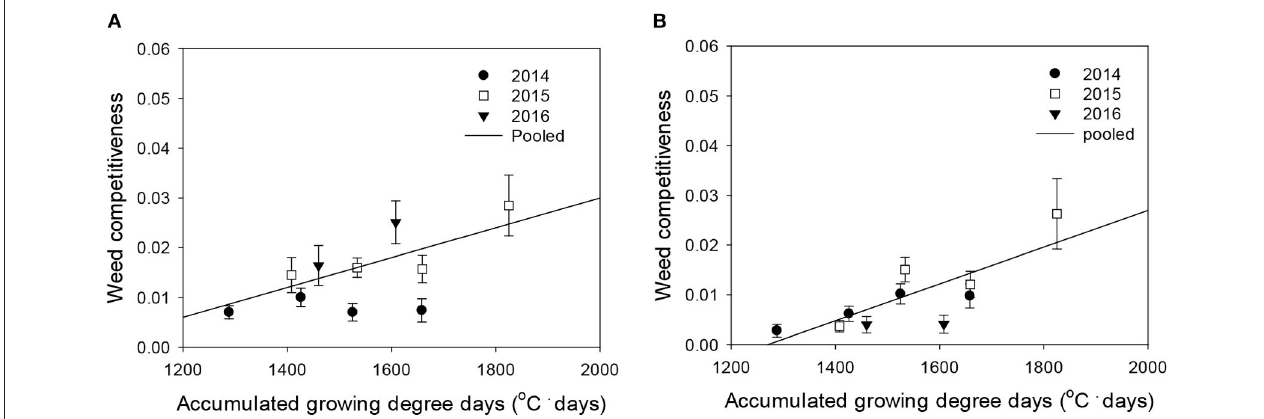
FIGURE 5 | Weed competitiveness ( β ) as a function of the accumulated growing degree days (from transplanting to flowering, 89 days) at four sunlit temperature-controlled phytotrons adjusted to ambient, + 1.5 ◦ C, + 3.0 ◦ C, and + 5.0 ◦ C in 2014, 2015, and 2016. The lines are fitted values calculated, using the linear model and parameter estimates ( Supplementary Table 3 ) in the pooled 3-year data of late watergrass (A) and water chestnut (B) . TABLE 3 | A summary of the nonlinear regression analysis and lack-of-fit test to compare the models for the regression of rice grain yield as a result of single-weed interference caused by late watergrass and water chestnut at accumulated growing degree days (from transplanting to flowering, 89 days) in the pooled 3-year data. Weed species Equation a Residual Number of parameters Test statistics df SS Comparison